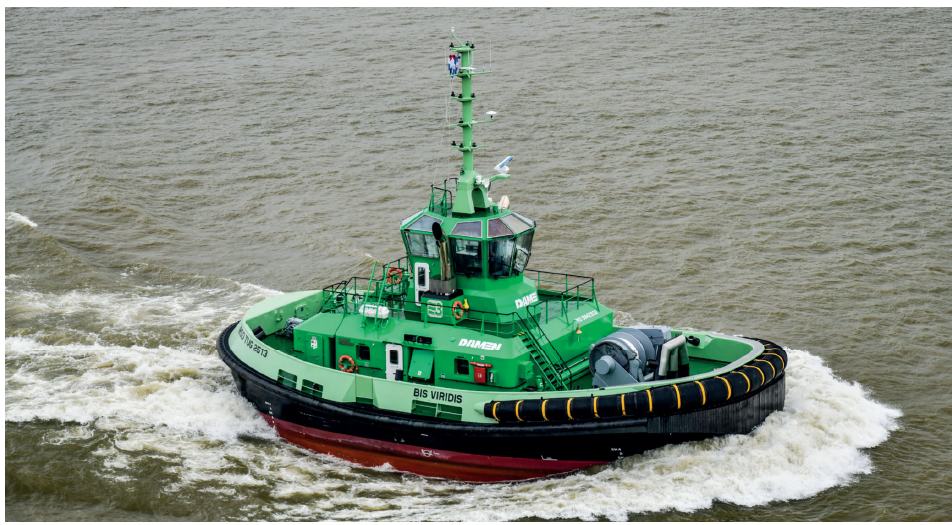
Figure 1. Damen RSD ‐ E Tug 2513 [23]. Figure 1. Damen RSD-E Tug 2513 [23].